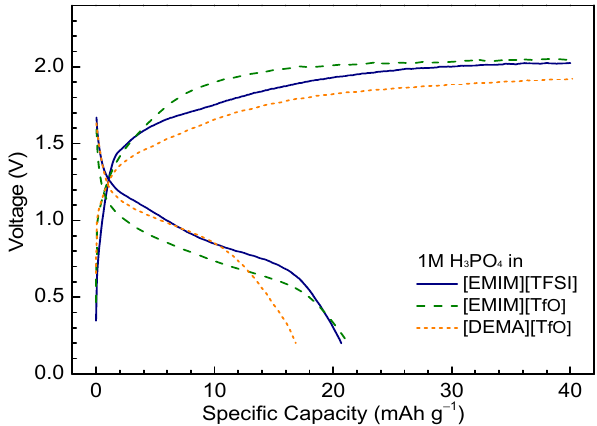
Figure 6. Electrochemical charge/discharge characteristics of Ni/MH half-cells using 1 M phosphoric acid with [EMIM][TFSI], [EMIM][TfO], and [DEMA][TfO]. Anode: AB5 MH